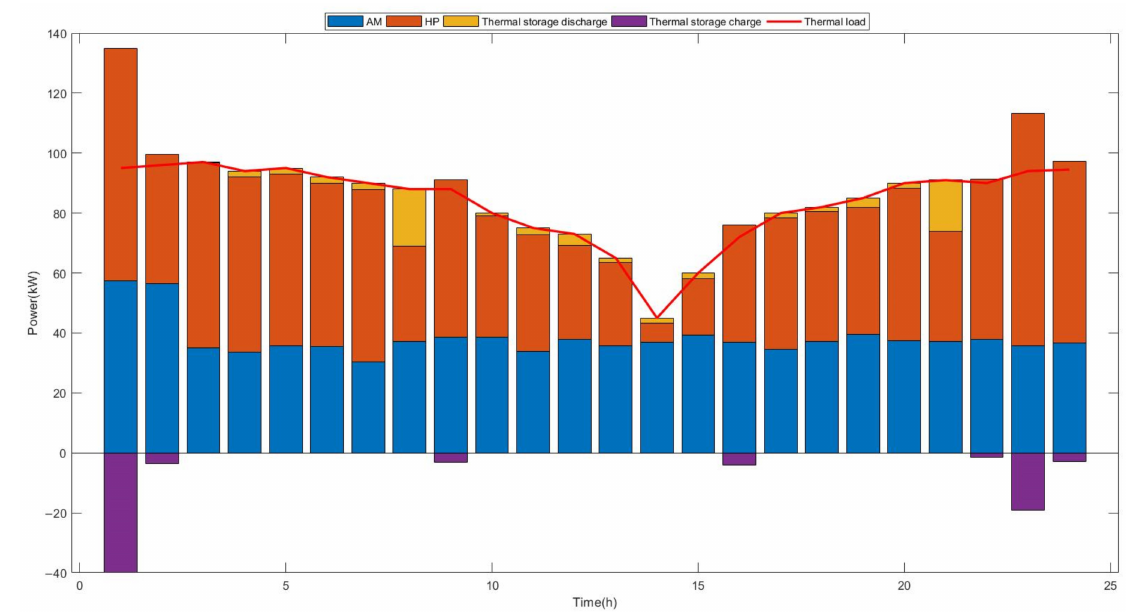
Figure 6. Optimal management of thermal elements of CHP microgrid.